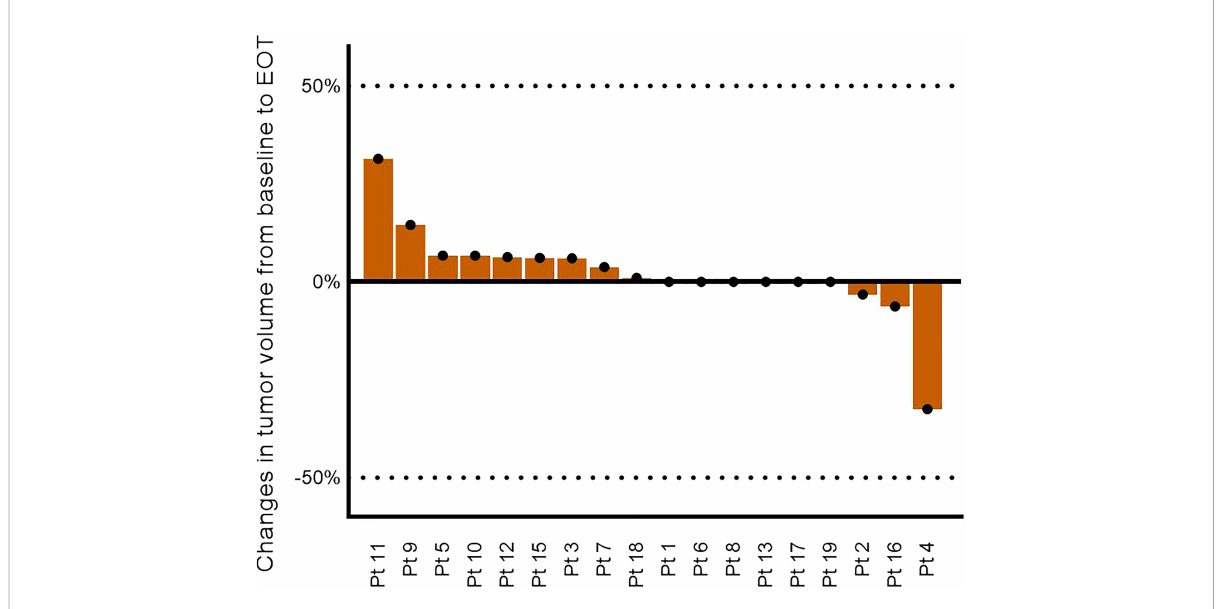
FIGURE 1 Changes in nodal tumor burden from baseline to end of treatment based on the sum of the largest diameter of target lymph nodes. Pt14 is not included due to exclusion from the